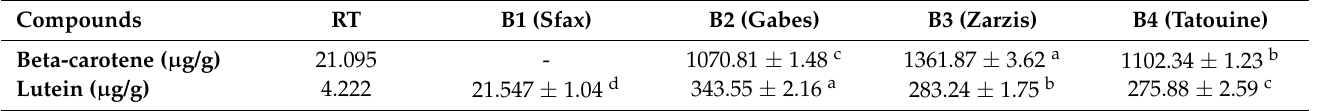
Table 2. Carotenoids level measured by HPLC. Results of B. tournefortii leaf extracts are presented as µ g/g of dry